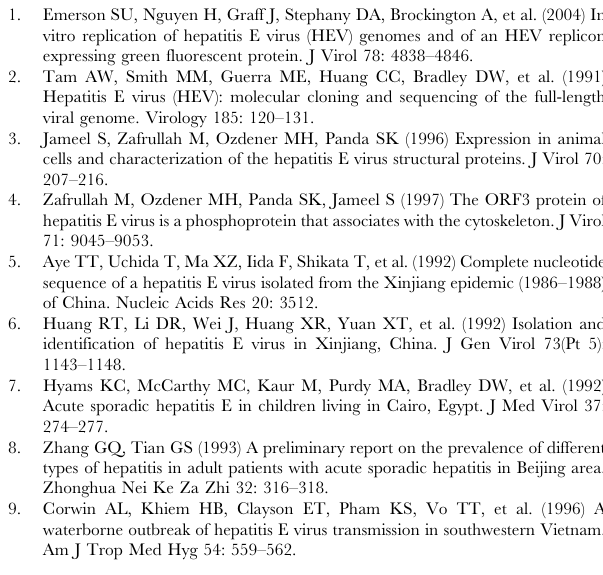
Table S1 HEV strains used in the phylogenetic and sequence analyses.